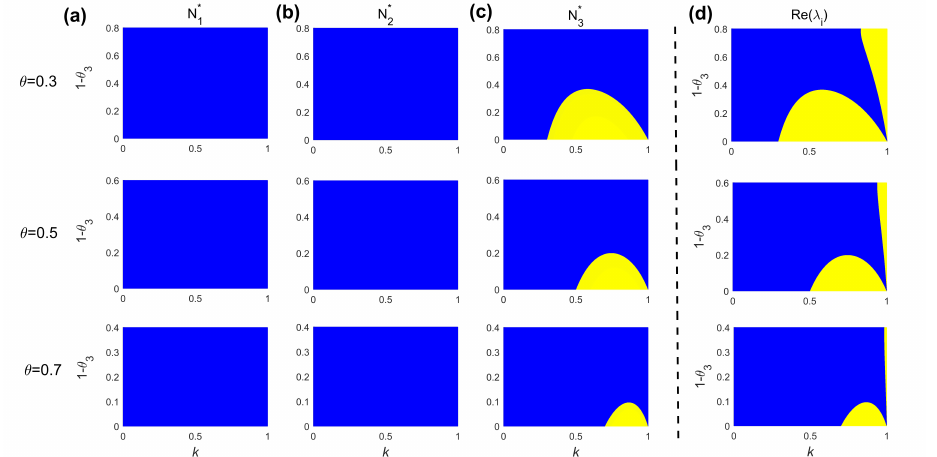
> 0, N ∗ > 0, N ∗ > 0 2 3 1 < 0, N ∗ < 0, N ∗ < 0 and Re ( λ ) > 0). We select the intersection i 2 3 1